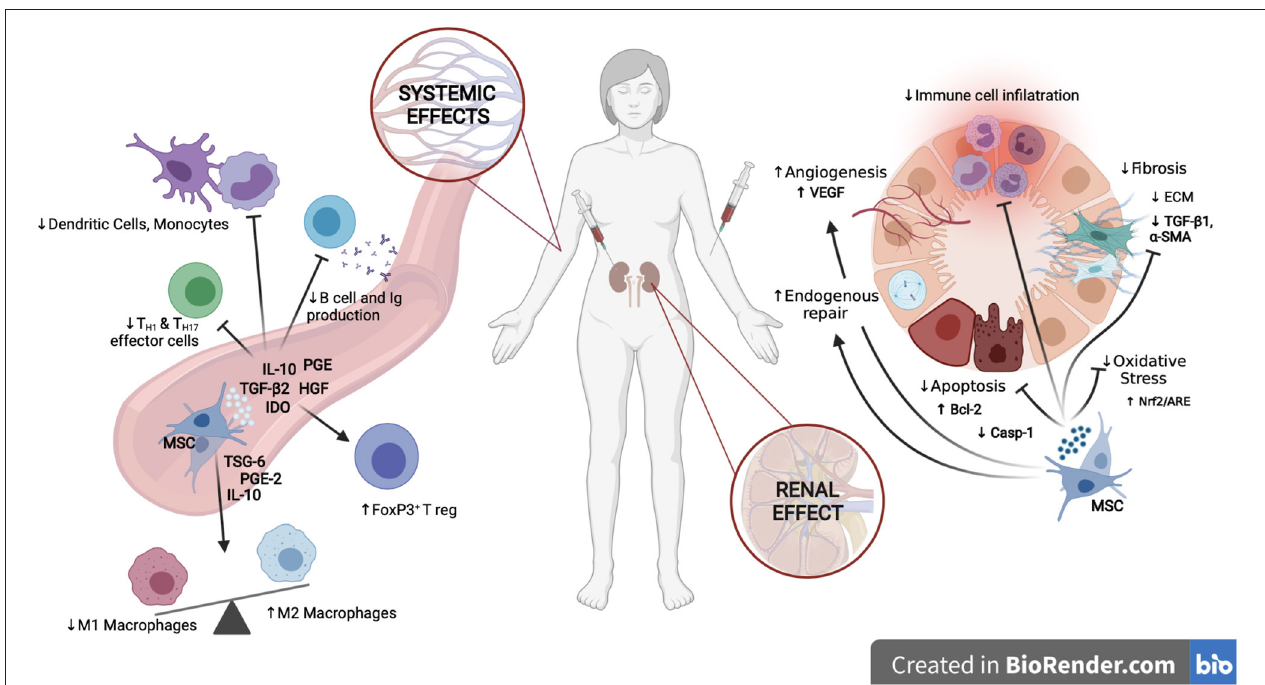
FIGURE 1 | Mechanisms of action of MSCs in kidney disease. At the renal level, MSCs enhance endogenous mechanisms of repair, confer cytoprotection by dampening apoptosis and oxidative stress, promote vascular preservation and regeneration, diminish renal fibrosis and reduce infiltration of immune cells, creating an anti-inflammatory and pro-regenerative environment. At the systemic level, MSCs inhibit the pro-inflammatory activities of both, the innate and adaptative immune system, enhancing the expansion of tolerogenic T reg and M2 Macrophages while inhibiting M1 macrophages, monocytes, dendritic cells, and T and B lymphocytes. Created in